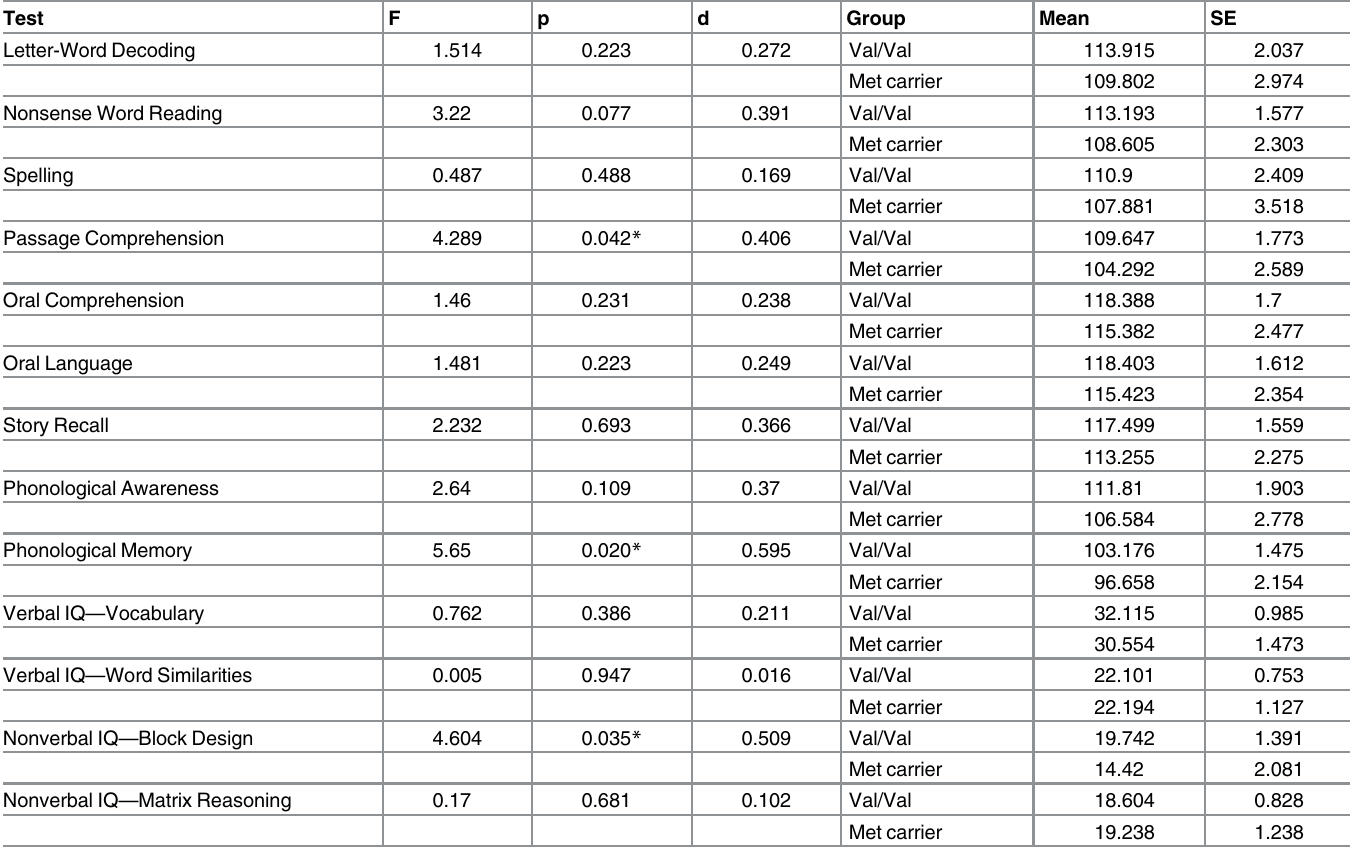
Table 2. Behavioral